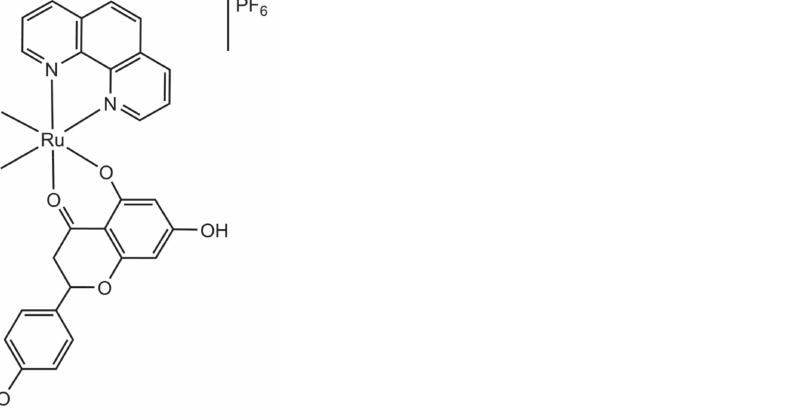
Figure 11. Structural representation of the cationic complex [Ru(naringenin)(phen) 2 ]PF 6 . The antimicrobial activity of [Ru(naringenin)(phen) 2 ]PF 6 was tested both in vitro